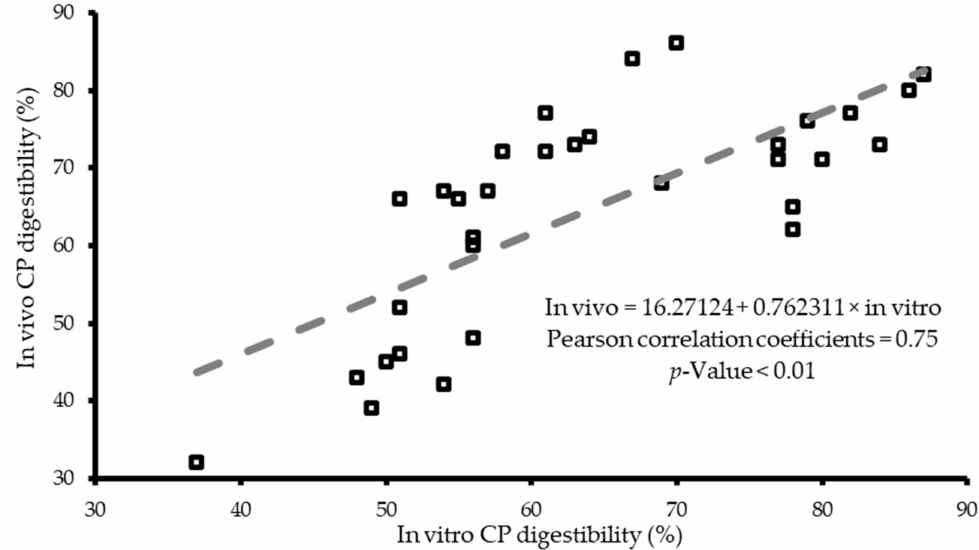
Figure 1. Plot of correlation between in vivo and in vitro crude protein (CP) digestible of nine high protein poultry feed ingredients